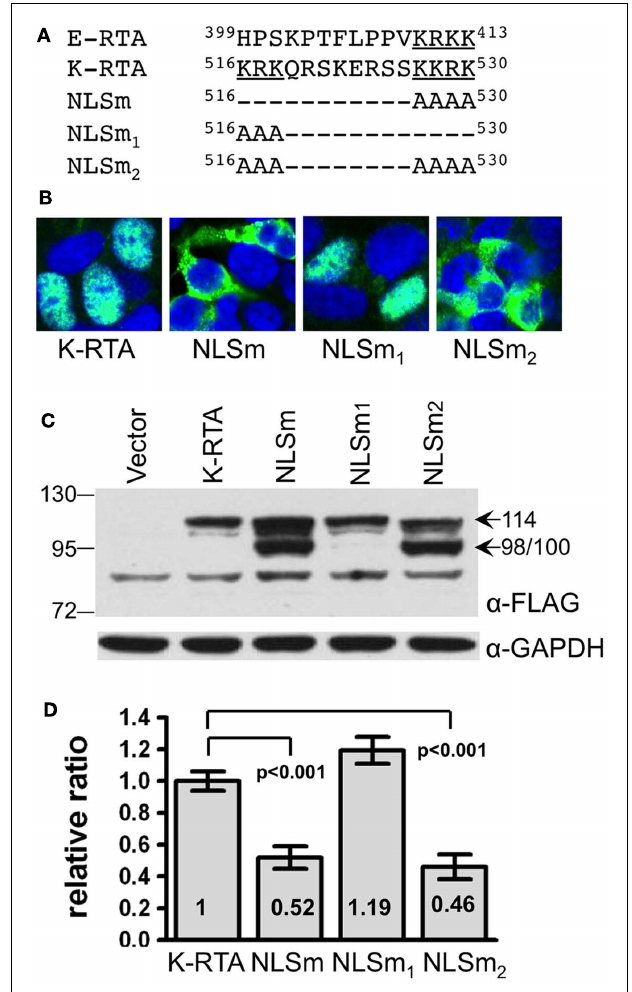
FIGURE 1 | Characterization of a prototypic bipartite nuclear localization signal (NLS) of K-RTA locating at amino acids 516–530. (A) Alignment of NLS from EBV Rta (E-RTA), K-RTA, NLSm, NLSm 1 , and NLSm 2 .The KRKK motif required for E-RTA nuclear localization (Hsu et al., 2005) and the two clusters of basic amino acids located in the bipartite NLS of K-RTA are underlined. (B) Subcellular localization of K-RTA and the three NLS mutants in HEK293 cells revealed by an immunofluorescence assay using M2 FLAG antibody followed by confocal microscopy. Only mutations locating at the second basic motif affect the nuclear targeting (NLSm and NLSm 2 ). (C) Western blot analysis of HEK293 cells transiently transfected with K-RTA or each of three NLS mutants. An additional 98/100 doublet was detected only in the extract of variants harboring the second basic motif mutation (NLSm and NLSm 2 ). GAPDH served as a loading control. (D) Luciferase reporter assay of KSHV ORF57 promoter responding to K-RTA and NLS mutants transiently expressed in HEK293 cells. Each firefly luciferase value was normalized to an internal control derived from cotransfected plasmid phRL-TK.The value in K-RTA was set to 1. Data are presented as means ± SD from triplicate transfections in an experiment. Statistical evaluations were performed by using Student’s t -test.Three independent experiments were performed; a representative result is